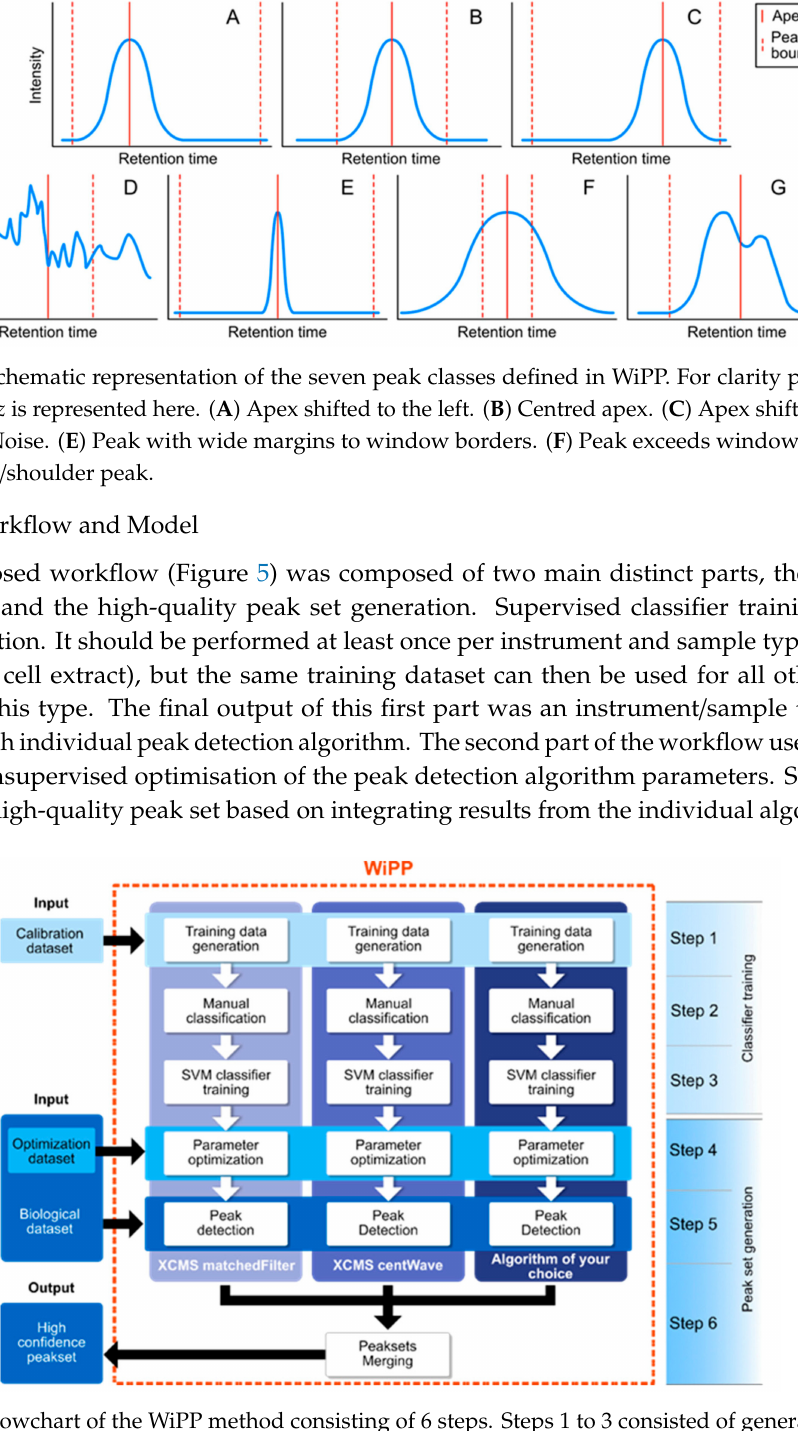
Figure 5. Flowchart of the WiPP method consisting of 6 steps. Steps 1 to 3 consisted of generating the training data and training the classifiers using a calibration dataset. Step 4 optimised the parameters of individual algorithms using an optimisation dataset and the trained classifiers. Step 5 ran the optimised peak detection algorithms on the full biological dataset. Step 6 classified, filtered, and merged the outputs of individual peak picking algorithms to generate a high-quality peak